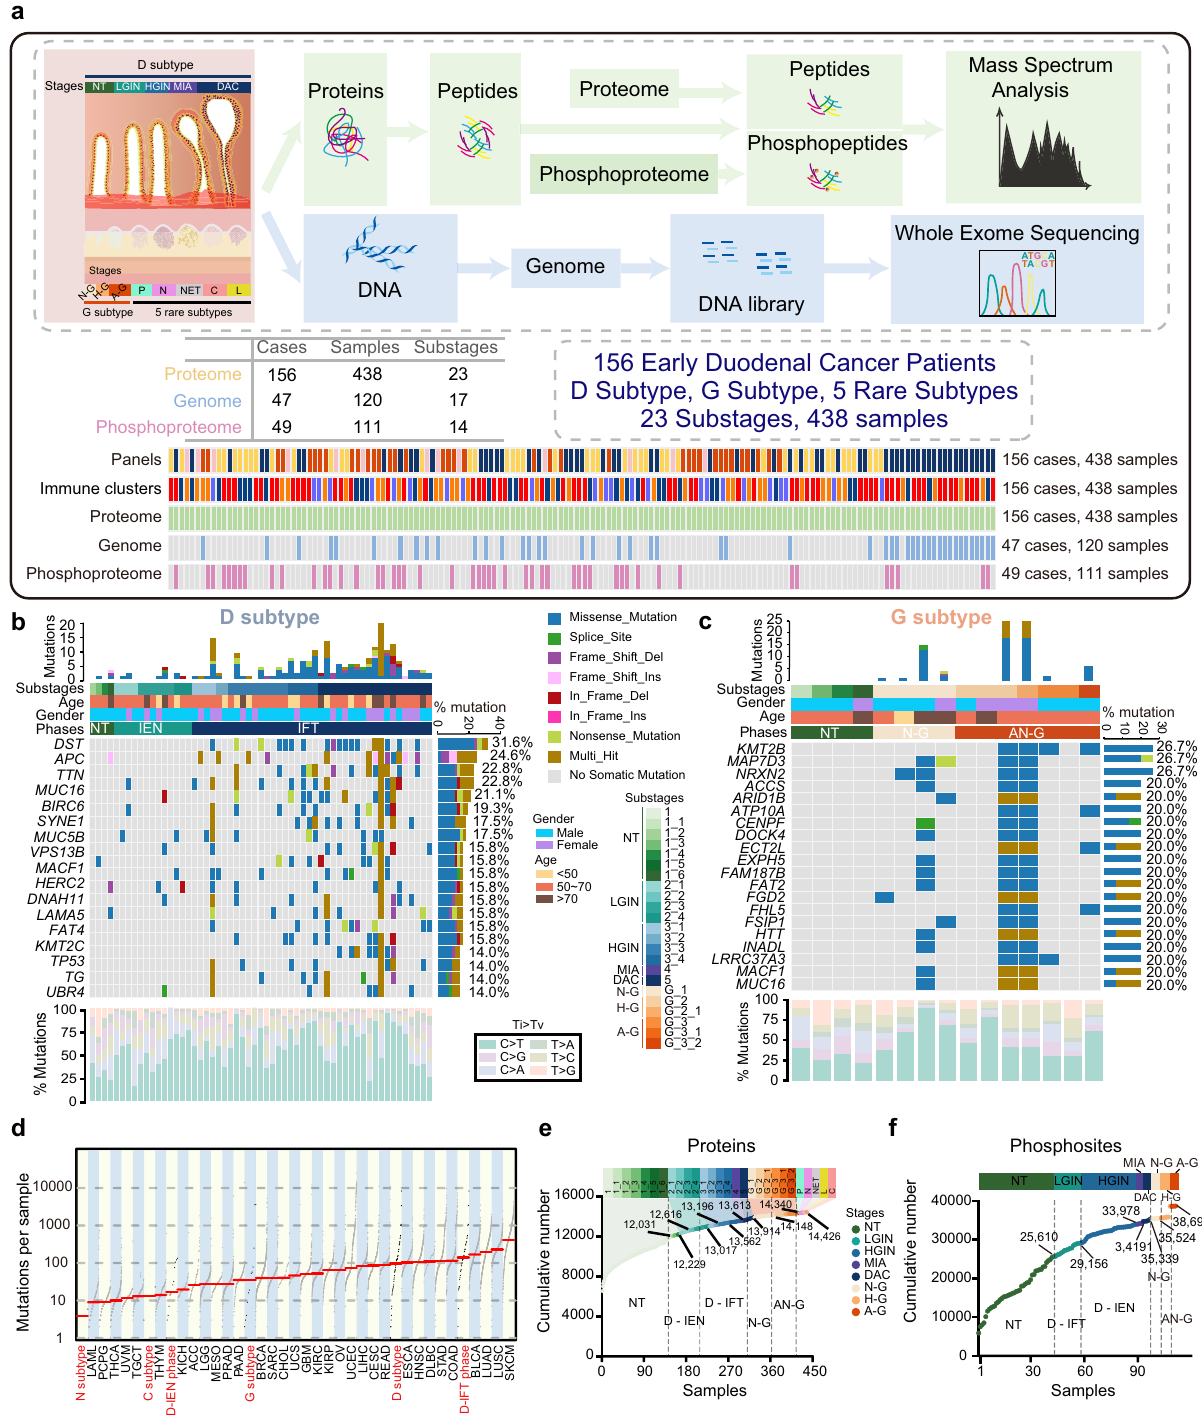
Fig.1|Multi-omicslandscapeinDCprogression.a Overviewoftheexperimental design and the number of samples for the genomic, proteomic, and phospho- proteomic analyses. The genomic pro fi les in the D subtype ( b ) and the G subtype ( c ) progression. Top: the mutation numbers and types of all the samples during carcinogenesis of DC. DC: duodenal cancer. Bottom: the percentages of somatic SNVsofallsamples.Themutationfrequenciesareshownbyabarplotontheright panel. The square directs to a subset of patient samples used for WES ( n =120).